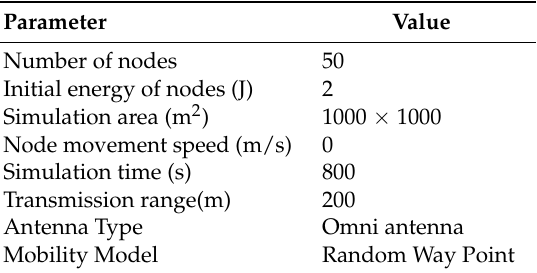
Table 2. Simulation parameters.